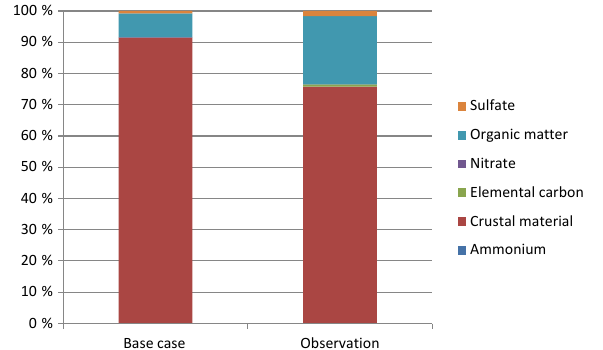
Figure 11. Comparison of the fugitive-dust PM speciation profile used for the base-case study and the one compiled from soil analy- ses from Wang et al. (2015) for the AOSR mining facilities.